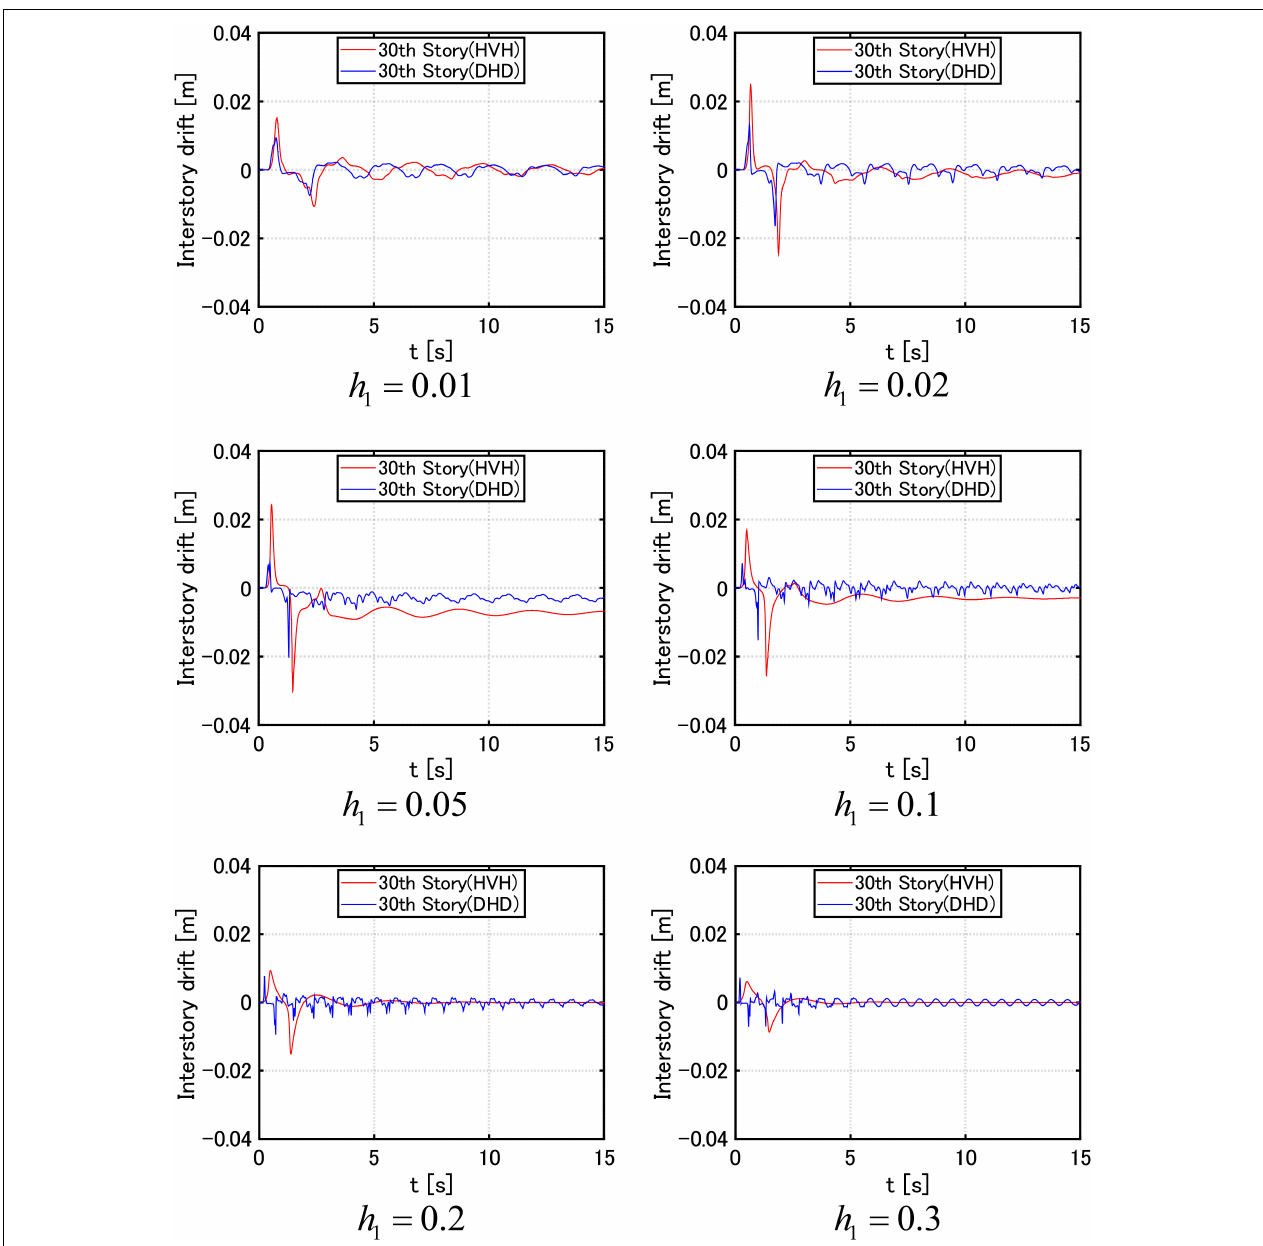
FIGURE 9 | Time history of 30th-story inter-story drift of MDOF systems with HVH system for various damping levels h 1 = 0 . 01 , 0 . 02 , 0 . 05 , 0 . 1 , 0 . 2 , 0 . 3 of viscous dampers and with DHD system of equivalent damper quantity of DSA (using Eq. (18)) under critical double impulse with V = 2.0 (m/s).